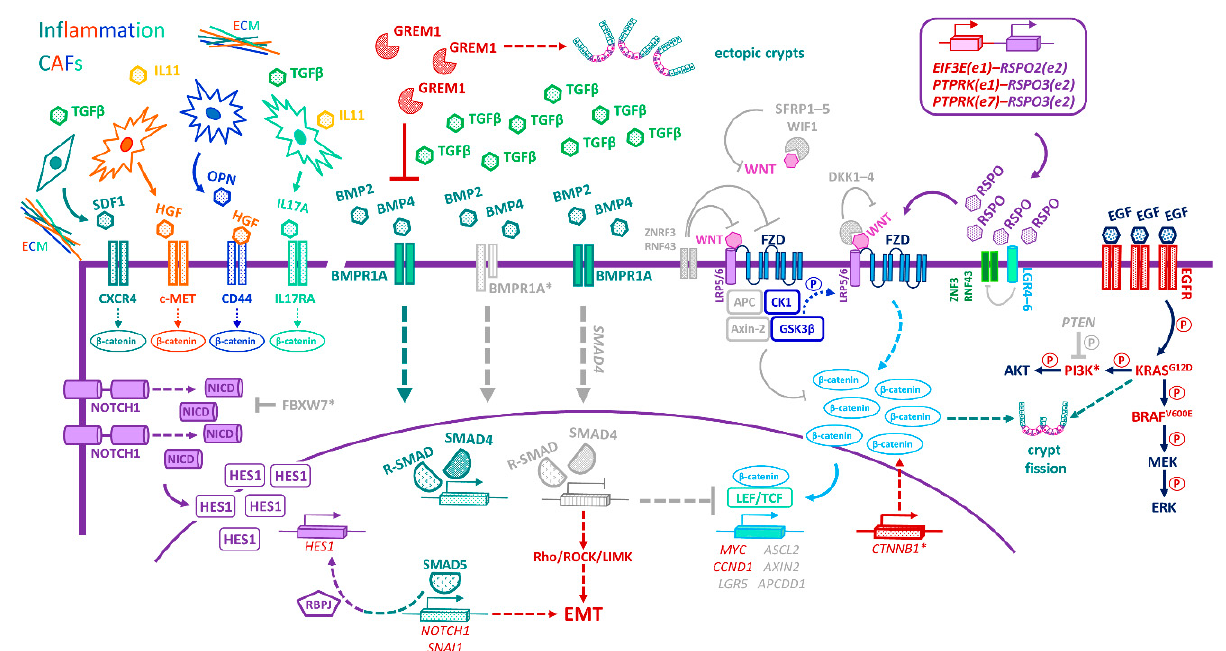
Figure 4. Mutations in components of niche-signalling pathways lead to “ISC emancipation” and subversion of homeostatic mechanisms. “ISC emancipation”, whereby ISCs gain autonomy from niche signalling, arises when a mutation either negates ISC dependence on pro-proliferative and pro-survival niche signals, or enables ISCs to evade growth-inhibitory stimuli. From right to left : Amplification of EGFR , activating mutations in KRAS ( KRAS G12D ), BRAF ( BRAF V600E ), or PIK3CA (which encodes PI3K), and PTEN loss-of-function mutations can stimulate MEK/ERK signalling, leading to increased proliferation and survival. The aberrant activation of Wnt signalling during CRC progression is associated with: (1) RSPO2/3 gene fusions that elevate RSPO levels in the TME, (2) epigenetic silencing of genes encoding secreted Wnt antagonists (WNT-ligand antagonists: SFRP1–5 and WIF1; WNT-receptor antagonists: DKK1–4), (3) loss-of-function mutations in negative feedback regulators of the Wnt pathway, such as APC , ZNRF3 , RNF43 , or Axin2 , or (4) activating mutations in CTNNB1 (which encodes β -catenin). The pro-proliferative Wnt-target genes MYC and CCND1 are typically overexpressed, whereas ISC-associated genes are often methylated in aggressive human tumours. Mutations in KRAS or APC correlate with increased crypt fission. Often found in human polyposis syndromes, disruption of BMP gradients (through overexpression of GREM1 or the acquisition of mutations in BMPR1A ) leads to the formation of ectopic crypts and polyps. SMAD4 deletion/mutation and/or deregulated TGF β signalling are further associated with niche independence, EMT, metastasis, and therapy resistance. An inflammatory drive exacerbates tumour progression, with activated CAFs and infiltrating tumour-associated populations elaborating multiple cytokines, including TGF β , IL11, HGF, OPN, SDF1, and IL17A, which stimulate Wnt/ β -catenin signalling and confer aggressive traits. Activation of Notch signalling in advanced tumours is associated with elevated levels of NOTCH1 and HES1, and inactivation of FBXW7, impairing NICD degradation. The Notch and BMP pathways synergize in a SMAD5-dependent manner to induce EMT, and BMPs activate Wnt/ β -catenin signalling in the context of SMAD4-deficiency. Grey colouring indicates suppression/inactivation, multiplicity of symbols and/or red denote aberrant upregulation/activation, asterisks signify unspecified mutations, and circled P indicates phosphorylation. Solid arrows indicate direct activation, dashed arrows signify multiple intermediary steps, and lines ending with a bar denote inhibition. CAFs, cancer-associated fibroblasts; ECM, extracellular matrix; EMT, epithelial-mesenchymal transition.